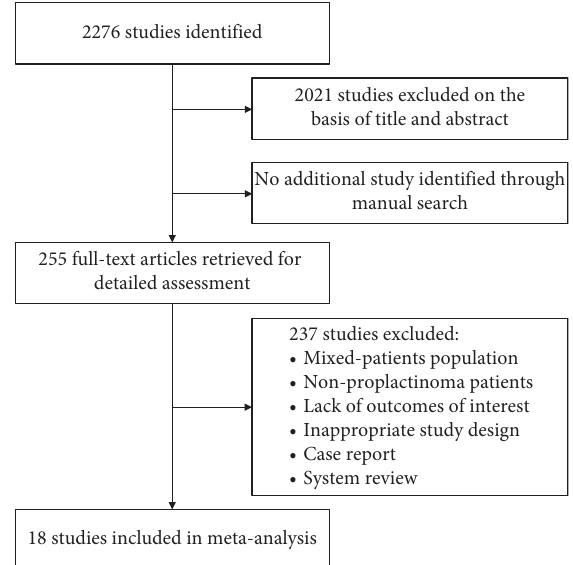
Figure 1: Flowchart of the literature search yield and selected